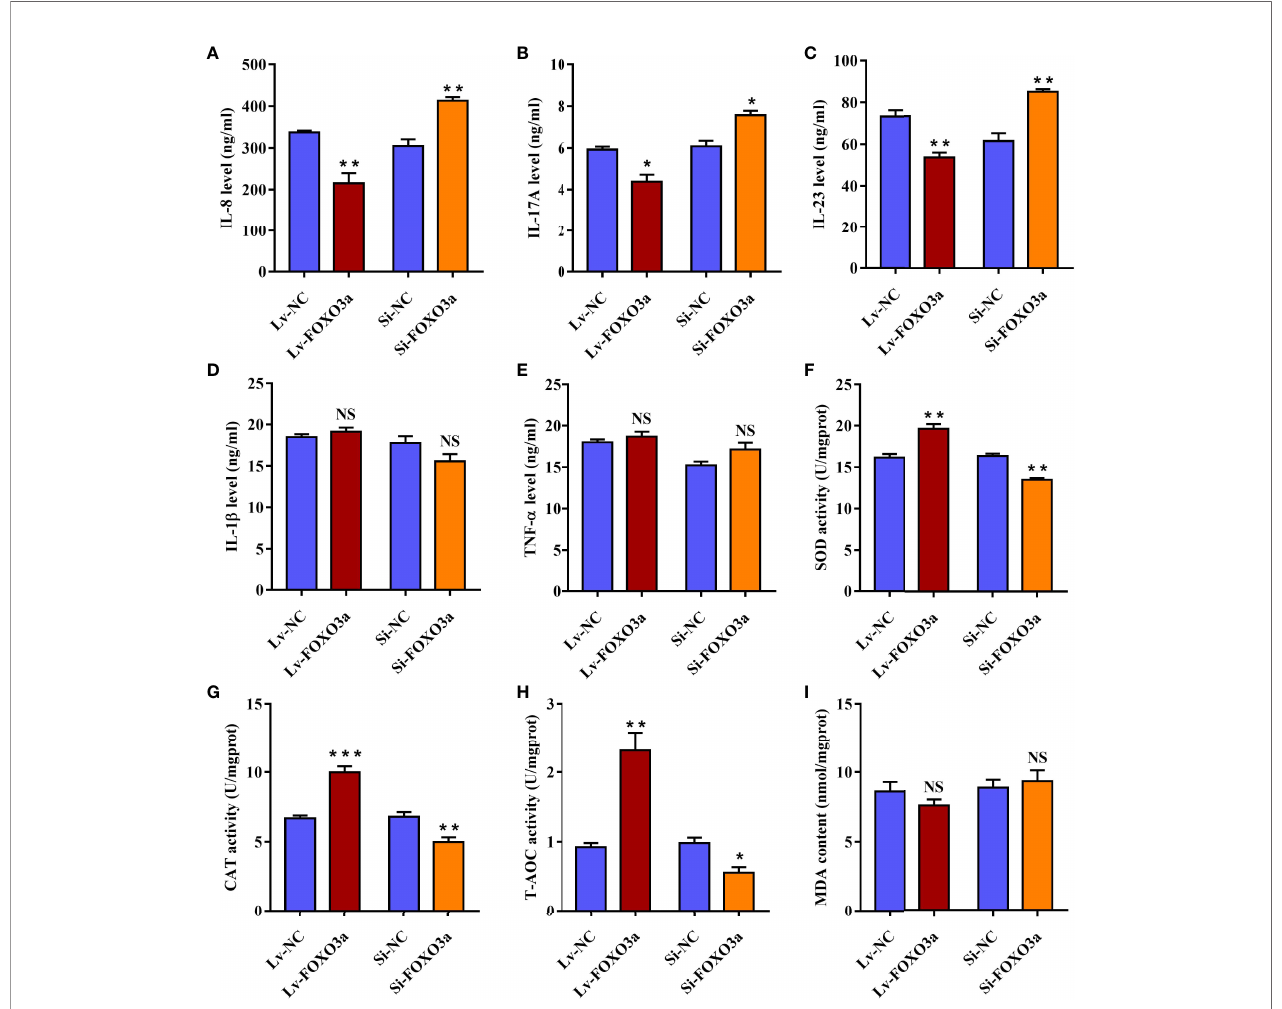
FIGURE 5 | FOXO3a modulates in fl ammation and oxidative stress in Jurkat cells. (A – E) Lv-FOXO3a and Si-FOXO3a markedly altered the levels of IL-8 (A) , IL-17A (B) , and IL-23 (C) , and but had no signi fi cant effect on IL-1 b (D) or TNF- a (E) . (F – H) Lv-FOXO3a obviously promoted the activities of SOD (F) , CAT (G) , and T-AOC (H) , which were obviously inhibited via Si-FOXO3a. (I) No remarkable difference on MDA was observed. All data were expressed as mean ± SEM of three independent experiments (n = 3). The differences between experimental group and NC group were analyzed using Student ’ s t-test. * P < 0.05, ** P < 0.01, *** P < 0.001; NS, not signi fi cant versus NC group. Lv-NC, lentivirus negative control, Lv-FOXO3a, FOXO3a overexpression; Si-NC, siRNA negative control; Si-FOXO3a, FOXO3a